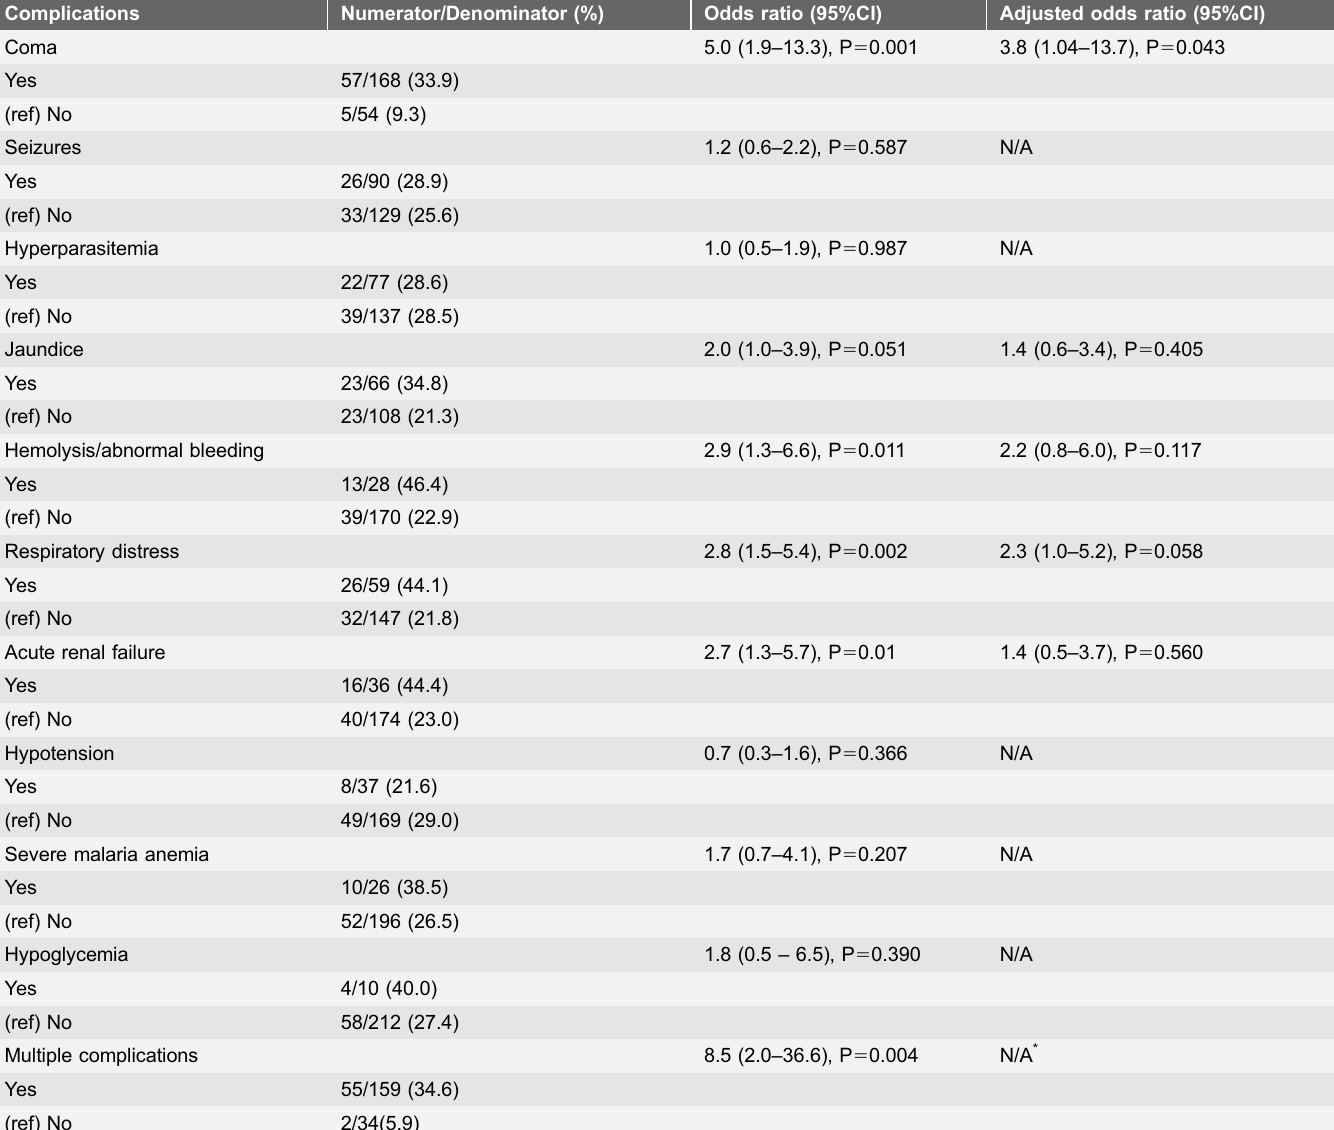
Table 6. Univariate and multivariate logistic regression analysis of different clinical complications associated with prognosis of enrolled complicated malaria (CM + SM) patients admitted at Maharani Hospital Jagdalpur, Chhattisgarh, India. Complications Numerator/Denominator